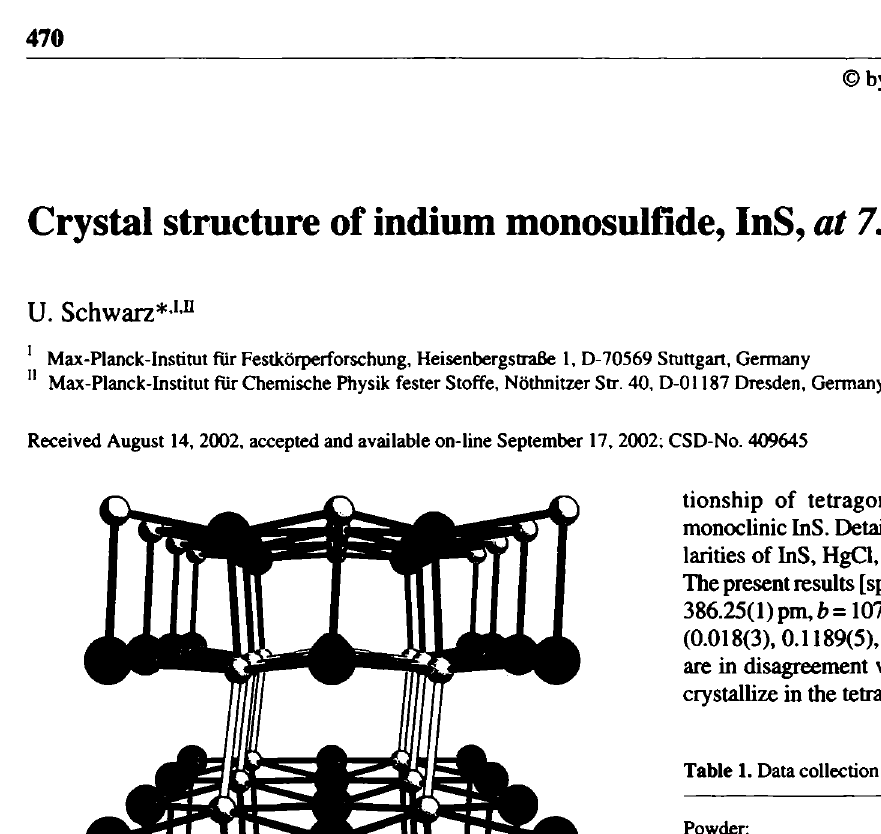
Table 1. Data collection and handling.